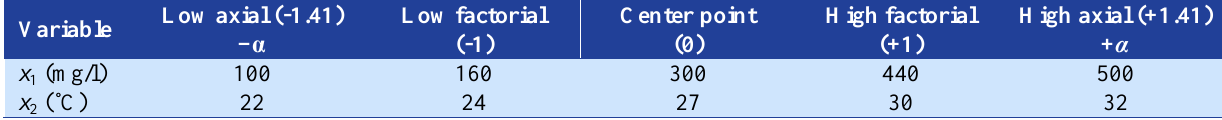
Table 1. Experimental range and levels of variables